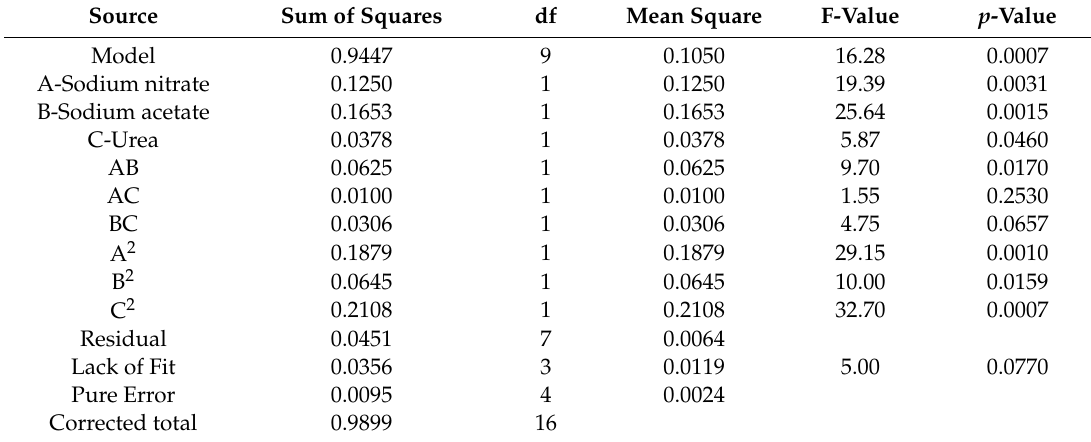
Table 5. ANOVA for the quadratic model of dry cell weight of C. vulgaris .